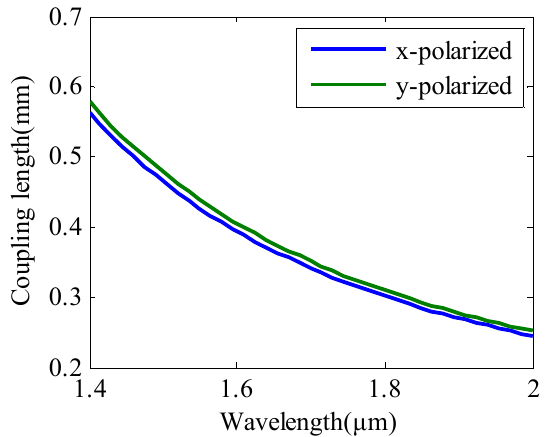
Figure 4. Coupling length for x and y polarizations with varying wavelength when the magnetic field is 90 Oe, d is 0.84 μ m, and Λ is 2.1 μ m.